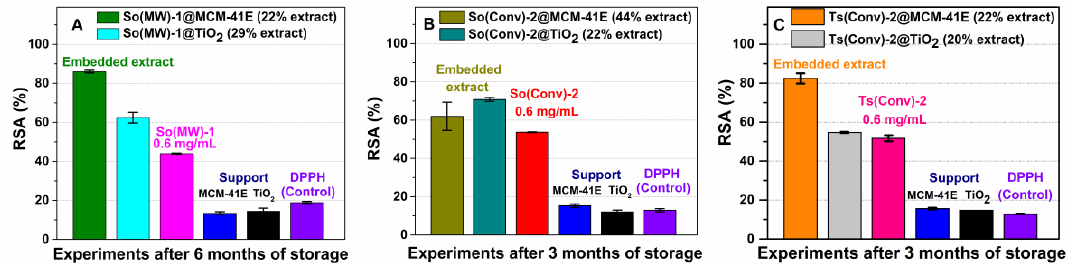
Figure 7. In vitro radical scavenger activity for ( A ) So(MW)-1 extract embedded in MCM-41E or TiO 2 ; ( B ) So(Conv)-2 extract embedded both supports; and ( C ) material containing Ts(Conv)-2, in comparison with the corresponding extract and support.